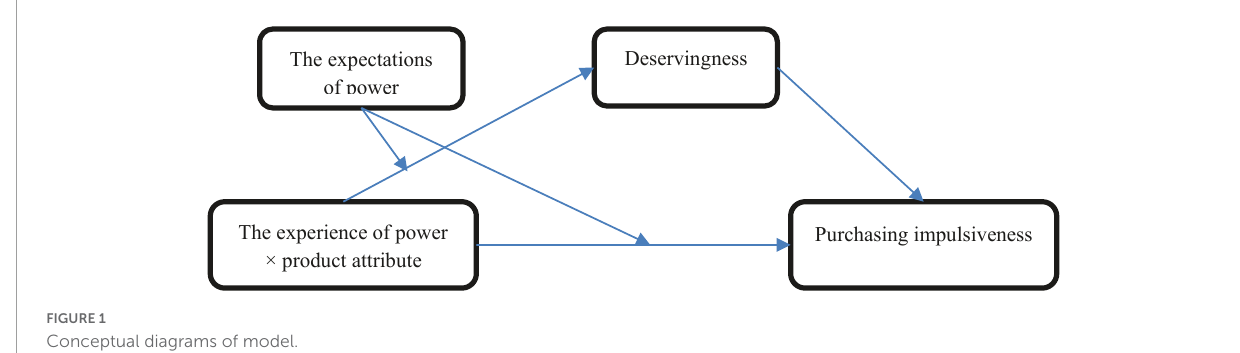
FIGURE1 Conceptual diagrams of